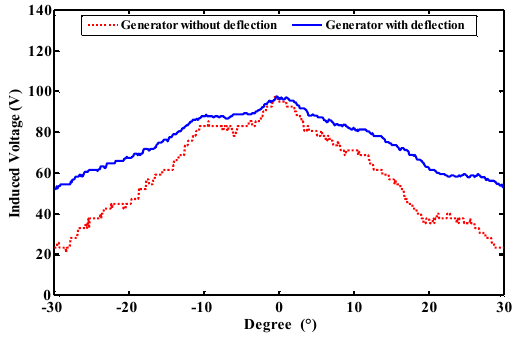
Figure 35. Voltage comparison curves post deflection.